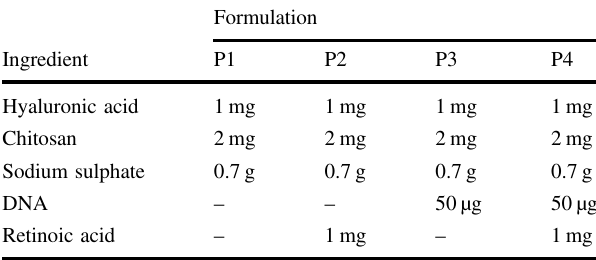
Table 1 Compositions of different formulations of